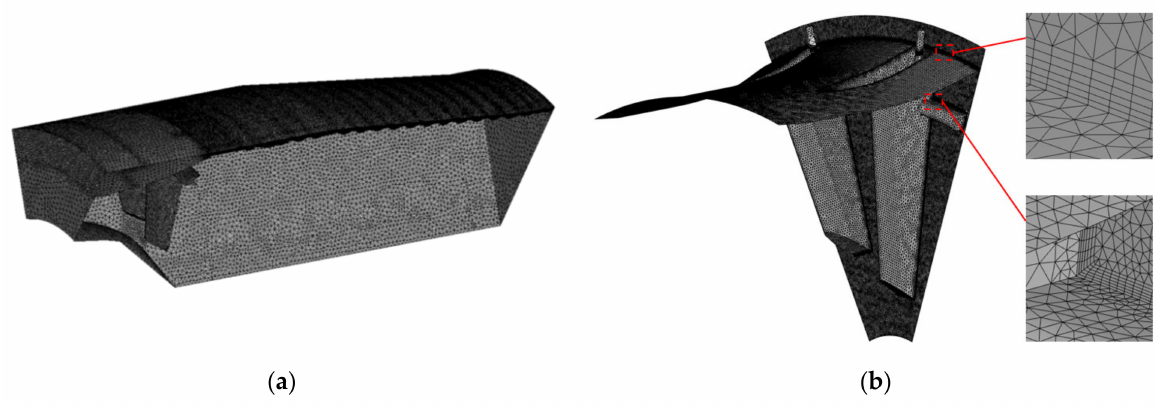
Figure 6. Surface mesh on various components of afterburner: ( a ) computational domain; ( b ) detailed view of flameholder and shunt ring.